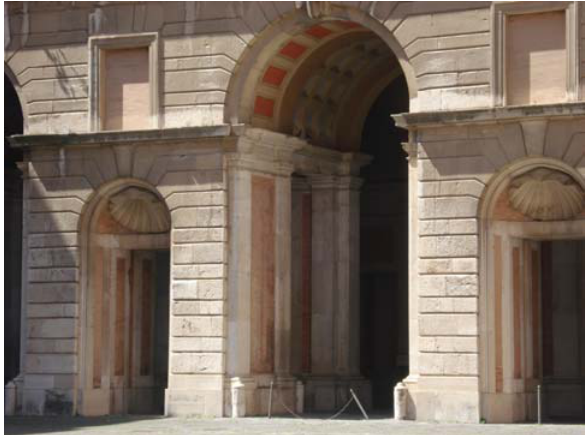
Figure 7 . Courtyard of Royal Palace in Caserta